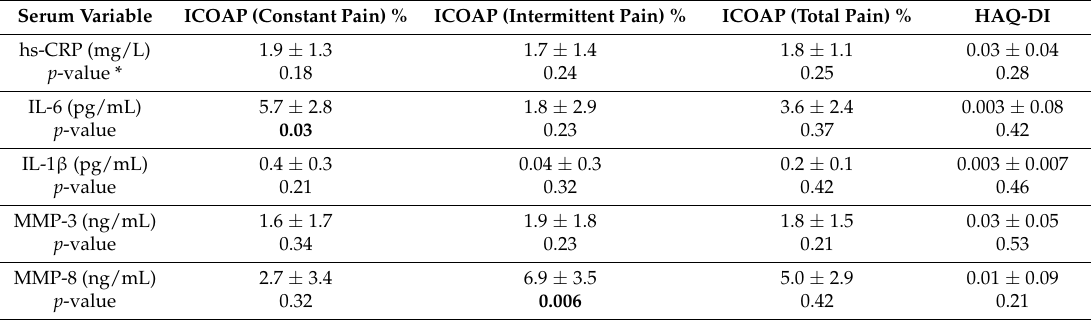
Table 3. Baseline associations of knee pain scores and Health Assessment Questionnaire-Disability Index with selected markers of inflammation and cartilage degradation in obese adults with symptomatic knee osteoarthritis (linear regression coefficients) ( n = 17).